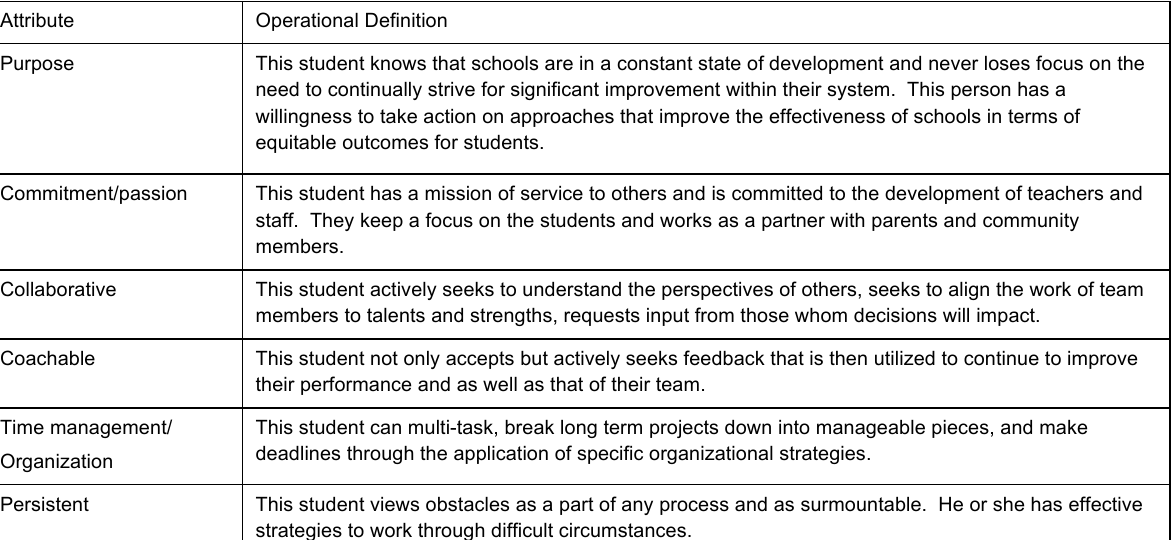
Table 2. Operational Definitions of Essential Attributes